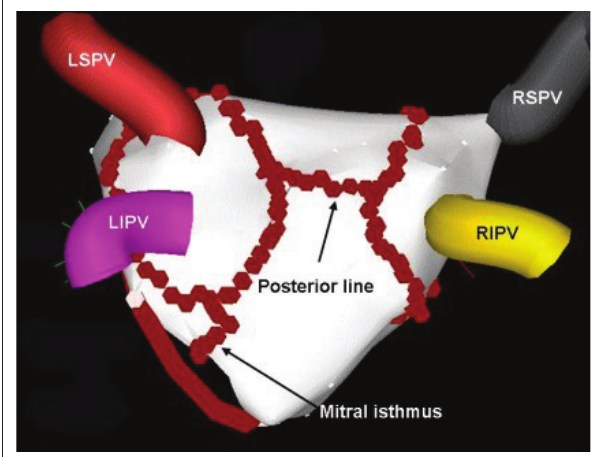
FIGURE 5: Illustration of ablation lines electrically isolating the different parts of the left atrium. Each line is made up of collinear punctiform ablation lesions without